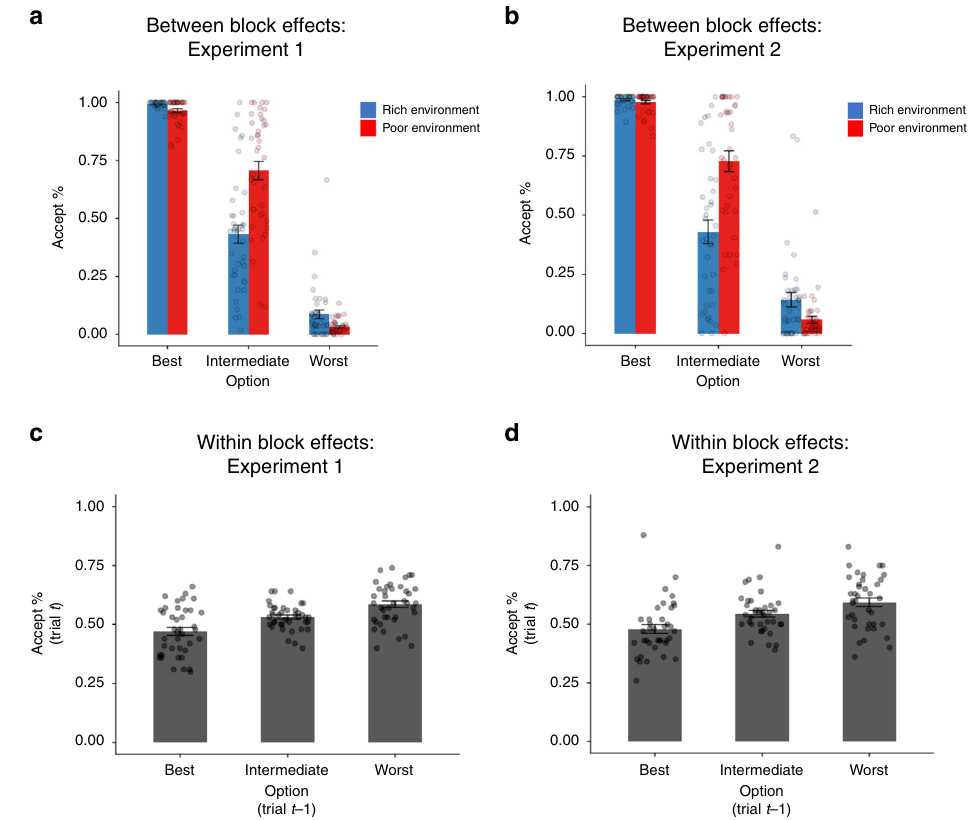
Fig. 2 Global and local effects of the environment. a , b Participants (Experiment 1, N = 40, Experiment 2, N = 38) increased their decision to accept according to how good each option was in terms of its reward per second and increased their decision to accept options overall in the poor compared to the rich environment. There was also an environment by option interaction driven by the change in acceptance between environments being greatest for the intermediate options compared to the best (Experiment 1: t (39) = 8.34, p = 3.3094E − 10; Experiment 2: t (37) = 5.60, p = 0.000002, two-sided paired sample t -tests on the change in acceptance rates between environments for intermediate versus best option) and worst (Experiment 1: t (39) = 9.89, p = 3.5216E − 12; Experiment 2: t (37) = 7.59, p = 4.6782E-9, two-sided paired sample t -tests on the change in acceptance rates between environments for intermediate versus worst option). c , d Acceptance rates were modulated by trial-to-trial dynamics. Participants (Experiment 1, N = 40, Experiment 2, N = 38) increased their acceptance rates for an option, the worse the previous option had been. Repeated measures ANOVA with previous option (best, intermediate, worst) and environment (rich, poor) as factors (main effect of previous option: Experiment 1: F (2, 78) = 43.69, p = 1.864E − 13; Experiment 2: F (2, 74) = 31.68, p = 1.1497E − 10). Best = high reward, low delay option; intermediate = low reward, low delay and high reward, high delay options combined; worst = low reward, high delay option. Dots represent individual data points; bars represent the group mean. Error bars represent mean ± standard error of the mean. Source data are provided as a Source Data fi